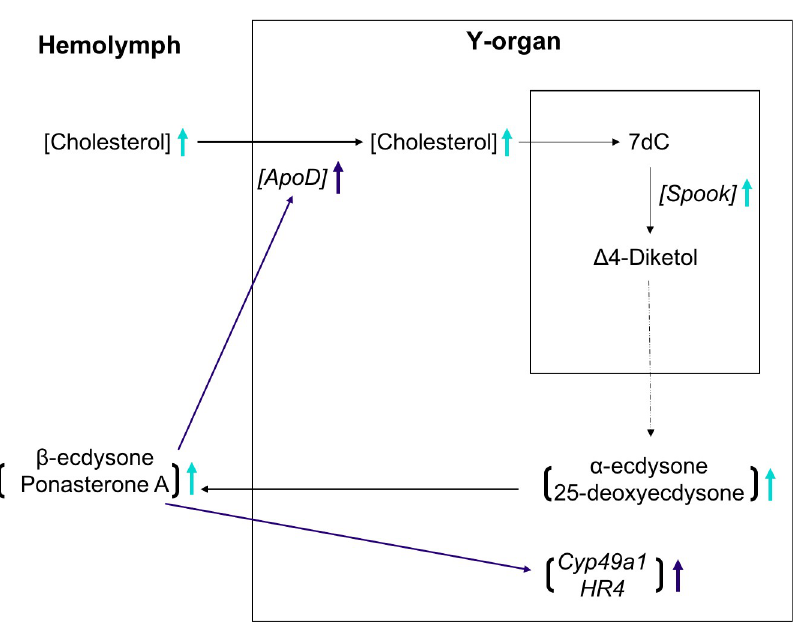
Fig 8. Summary of the ecdysteroidogenesis pathway in C . sapidus based on the data presented in this study. First, cholesterol concentration increased at early premolt (ePM, turquoise in Fig 7), resulting in the initial rise in ecdysone synthesis and release via upregulation of Neverland ( Nvd) and Spook . Then this initially elevated ecdysone in hemolymph upregulated Apolipoprotein D-like ( ApoD ) at premolt (PM, dark blue, in Fig 7) for further increase in cholesterol transport for ecdysteroid synthesis. It also upregulated other ecdysone responsive genes, including probable cytochrome p450 49a1 ( cyp49a1 ) and Hormone receptor 4 ( HR4 ) at PM. The dashed line represents the rest of the ecdysteroidogenesis steps not included in this study. The upward arrows illustrate the upregulation. 7dC: